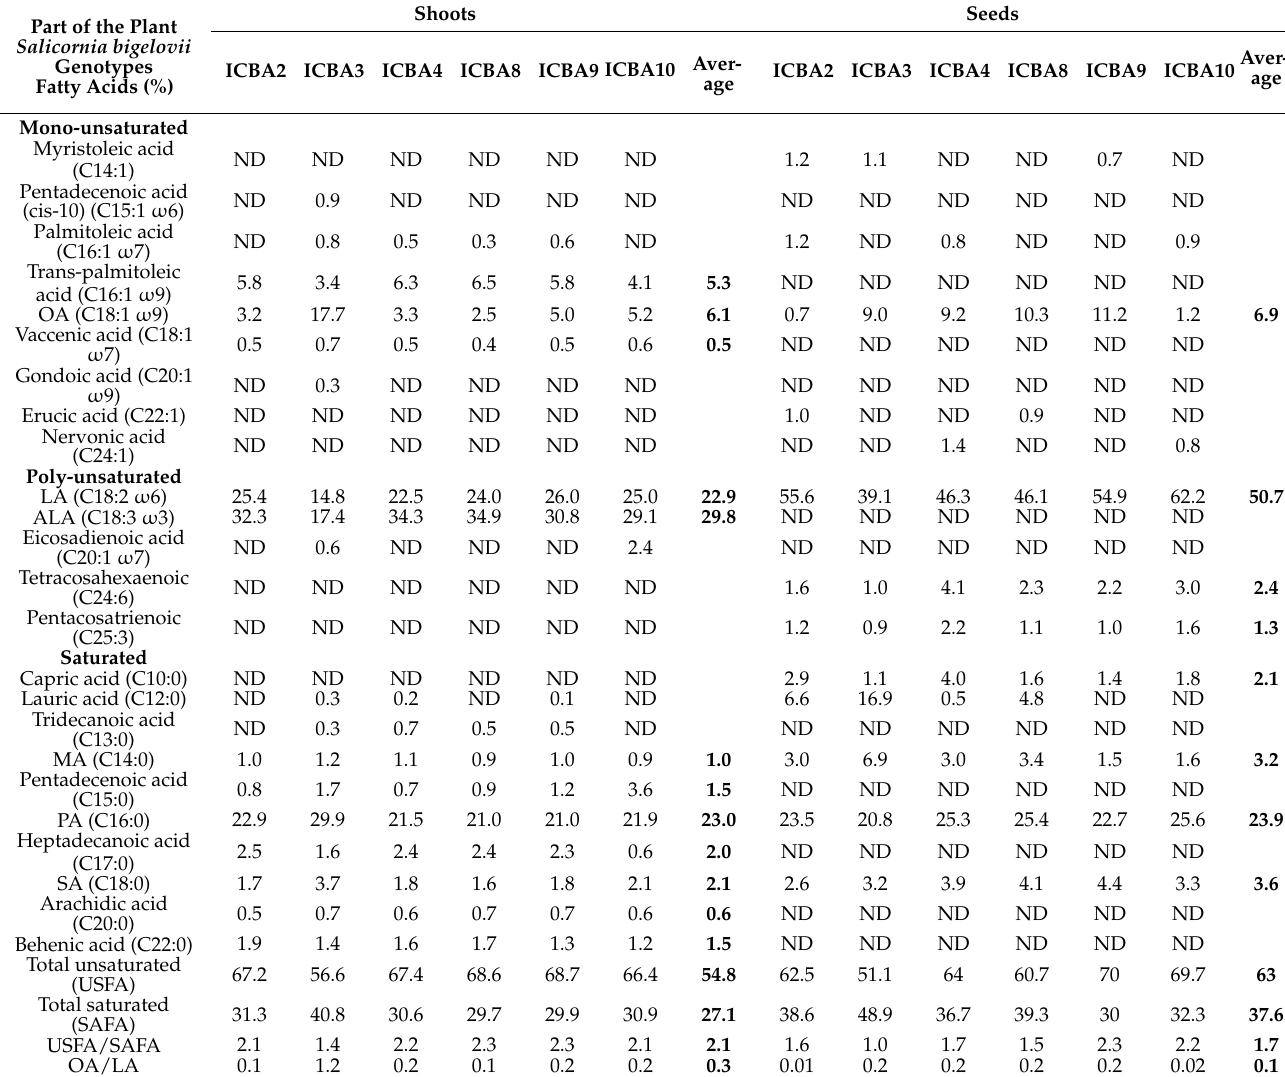
Table A6. Fatty acids composition (in percent) analyzed for shoots and seeds of six Salicornia bigelovii genotypes at Mubarak Valley in Egypt. The average value per parameter from all genotypes was calculated (in bold) for each